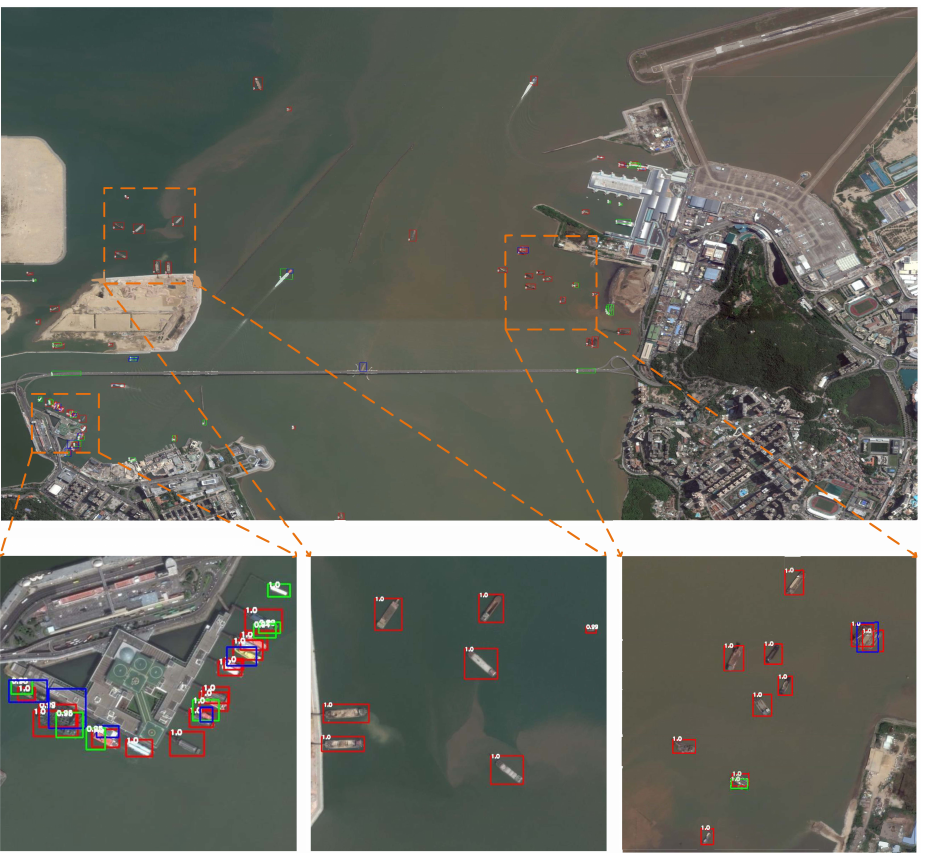
Figure 12. The detection results of IMAGE2. The true positives, false positives and false negatives are indicated by red, green and blue rectangles. The top left corner of the rectangle shows the confidence.